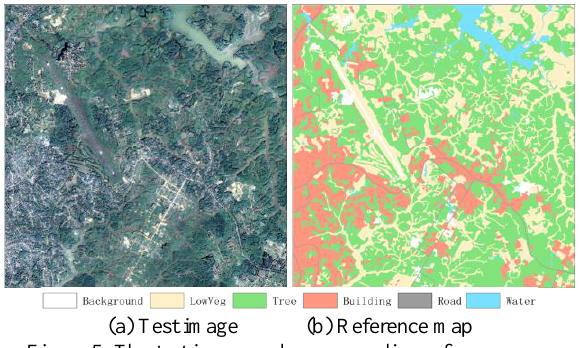
Figure 5. The test image and corresponding reference